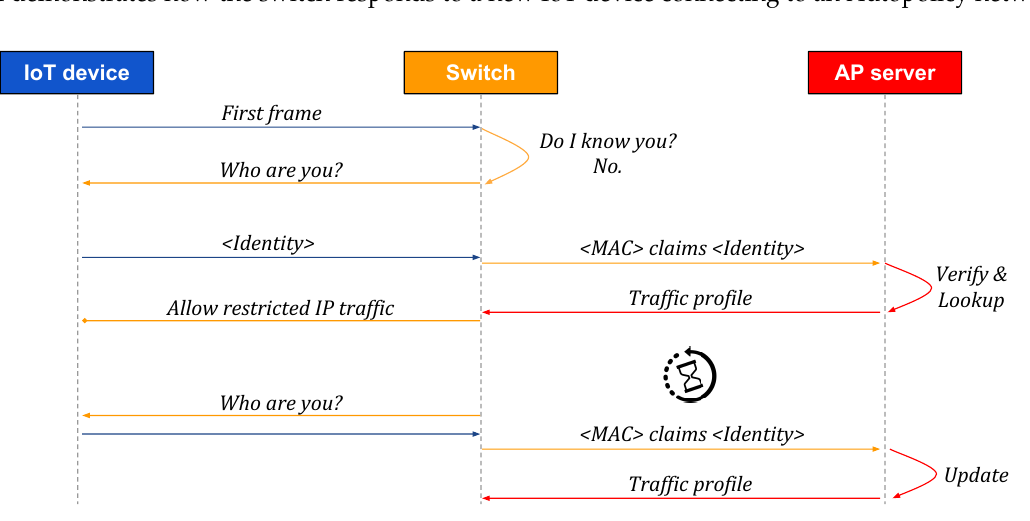
Figure 2. Sequence of messages: an IoT device that supports Autopolicy connects to a protected network. The switch forwards its identity file to the Autopolicy server (AP server), which verifies it and replies with a traffic profile. The procedure is periodically repeated for possible profile